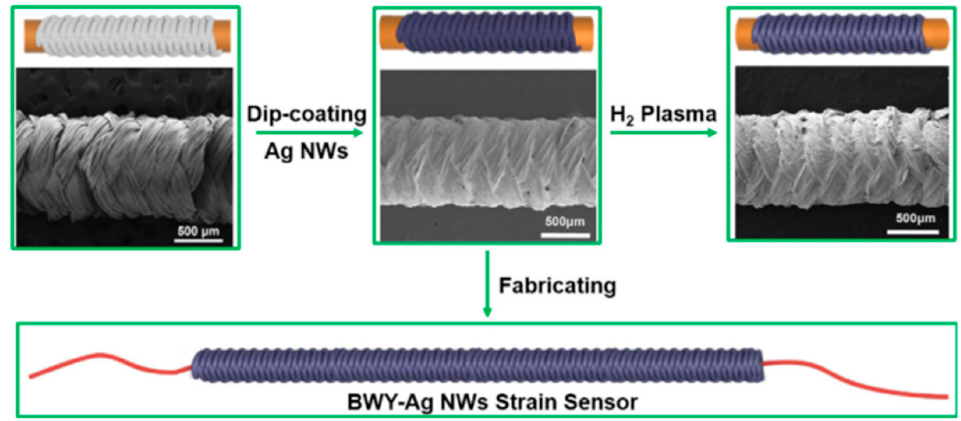
Figure 9. Schematic diagram of the manufacturing process of the BWY-Ag NW strain sensor [97].